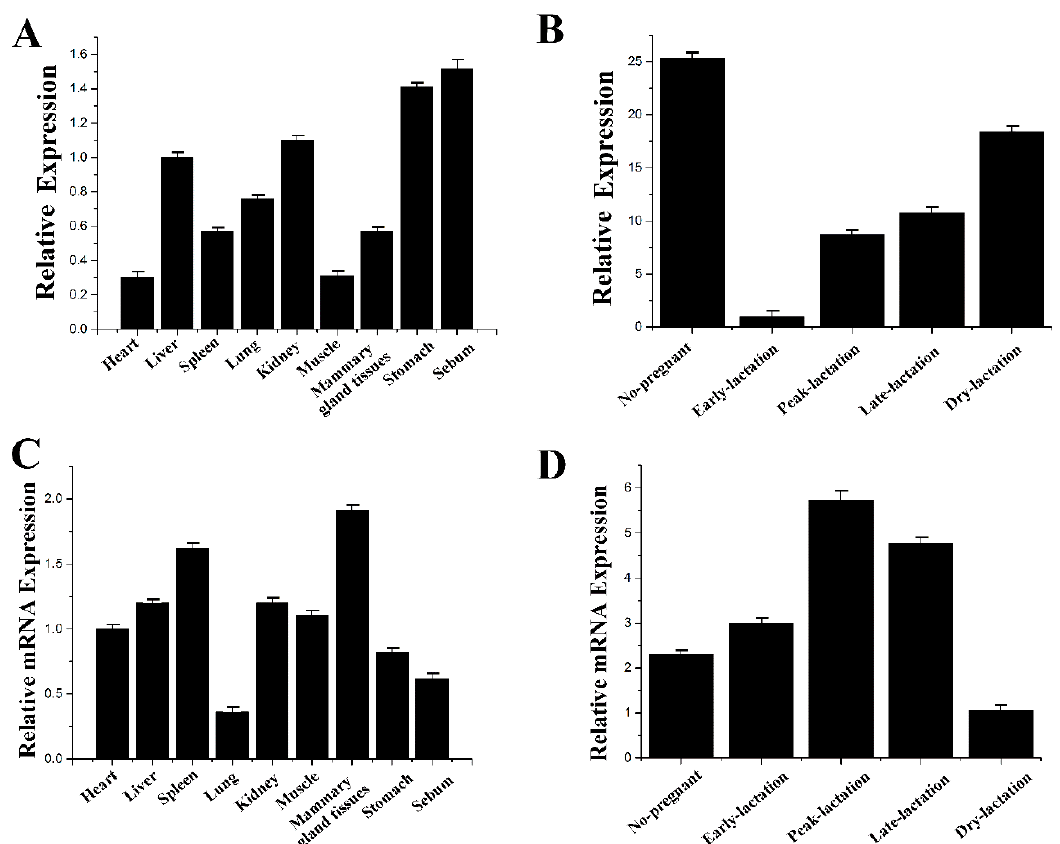
Figure 6. The expression level of miR-183 and IRS1. ( A ) miR-183 expression in various tissues of milk cows. ( B ) miR-183 expression in various periods of milk cows. ( C ) IRS1 expression in various tissues of milk cows. ( D ) IRS1 expression in various periods of milk cows. All experiments were duplicated and repeated three times. Values are presented as means ± standard deviation.